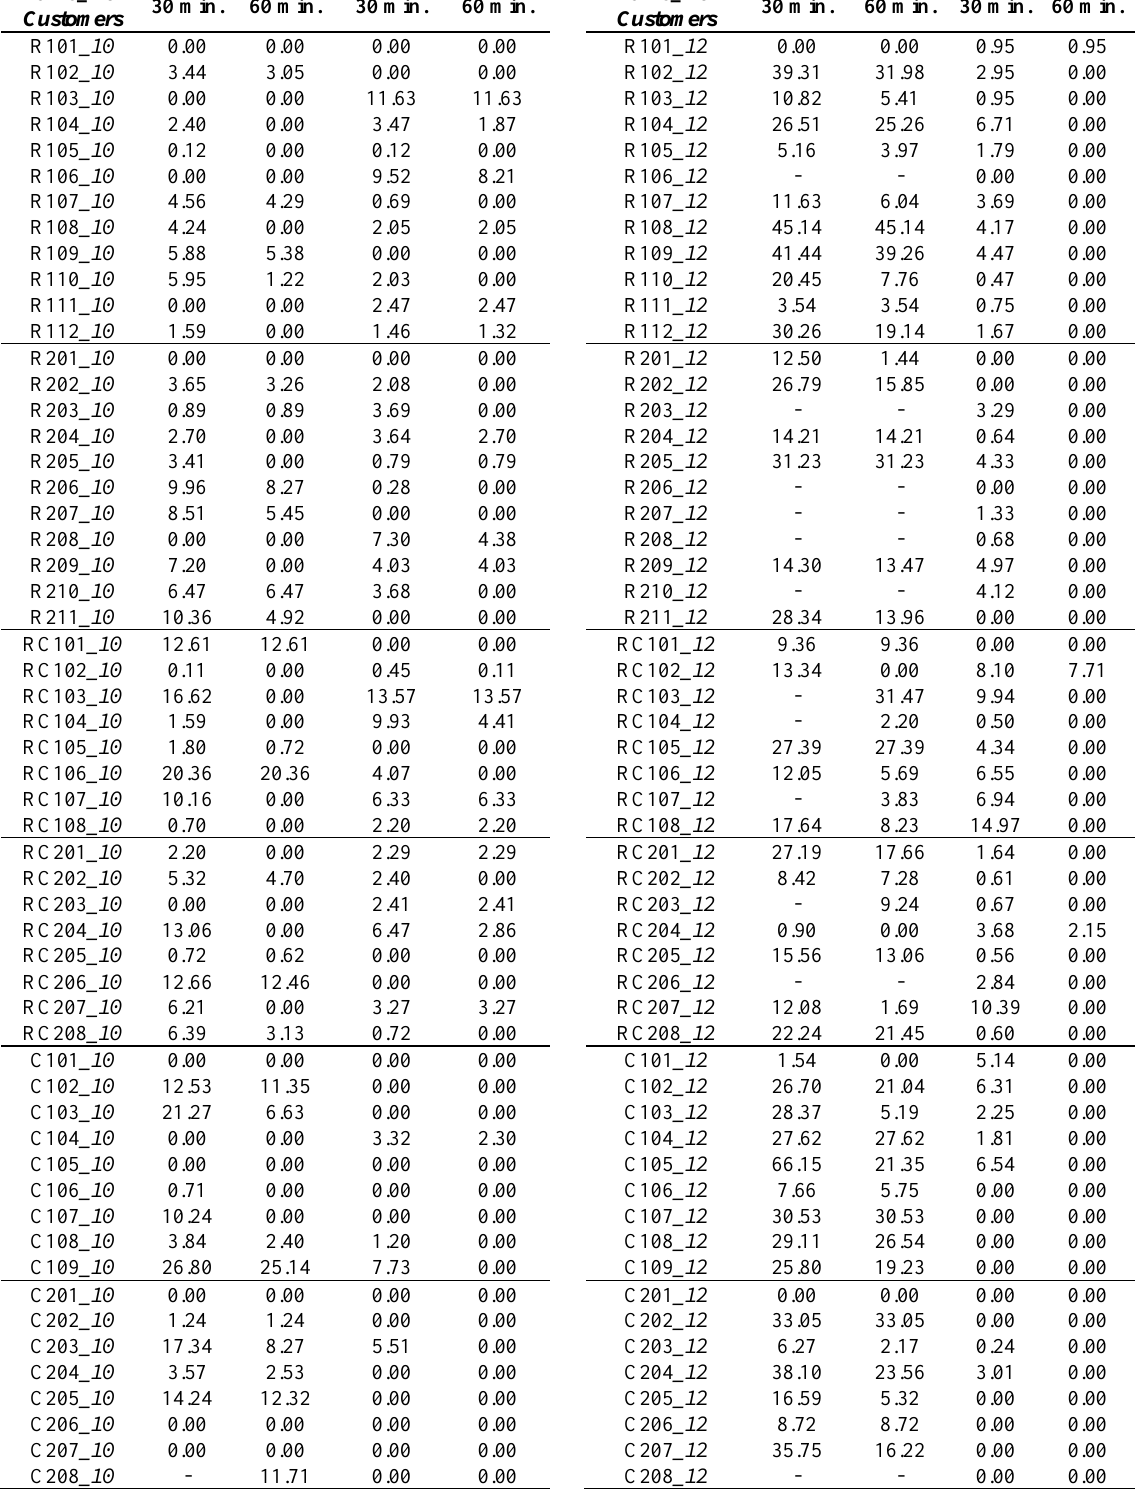
Table A3. The RPD results for instances with 10 customers. Table A4. The RPD results for instances with 12